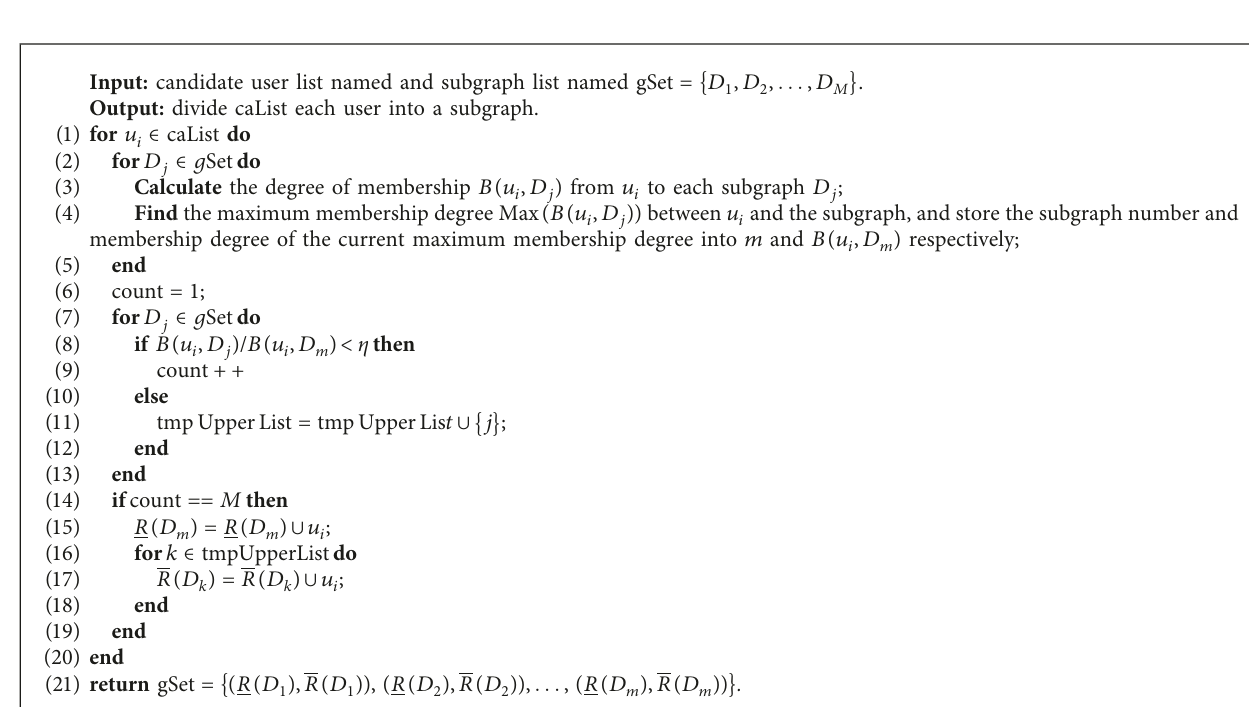
A LGORITHM 1: Selecting center node of subgraph algorithm.